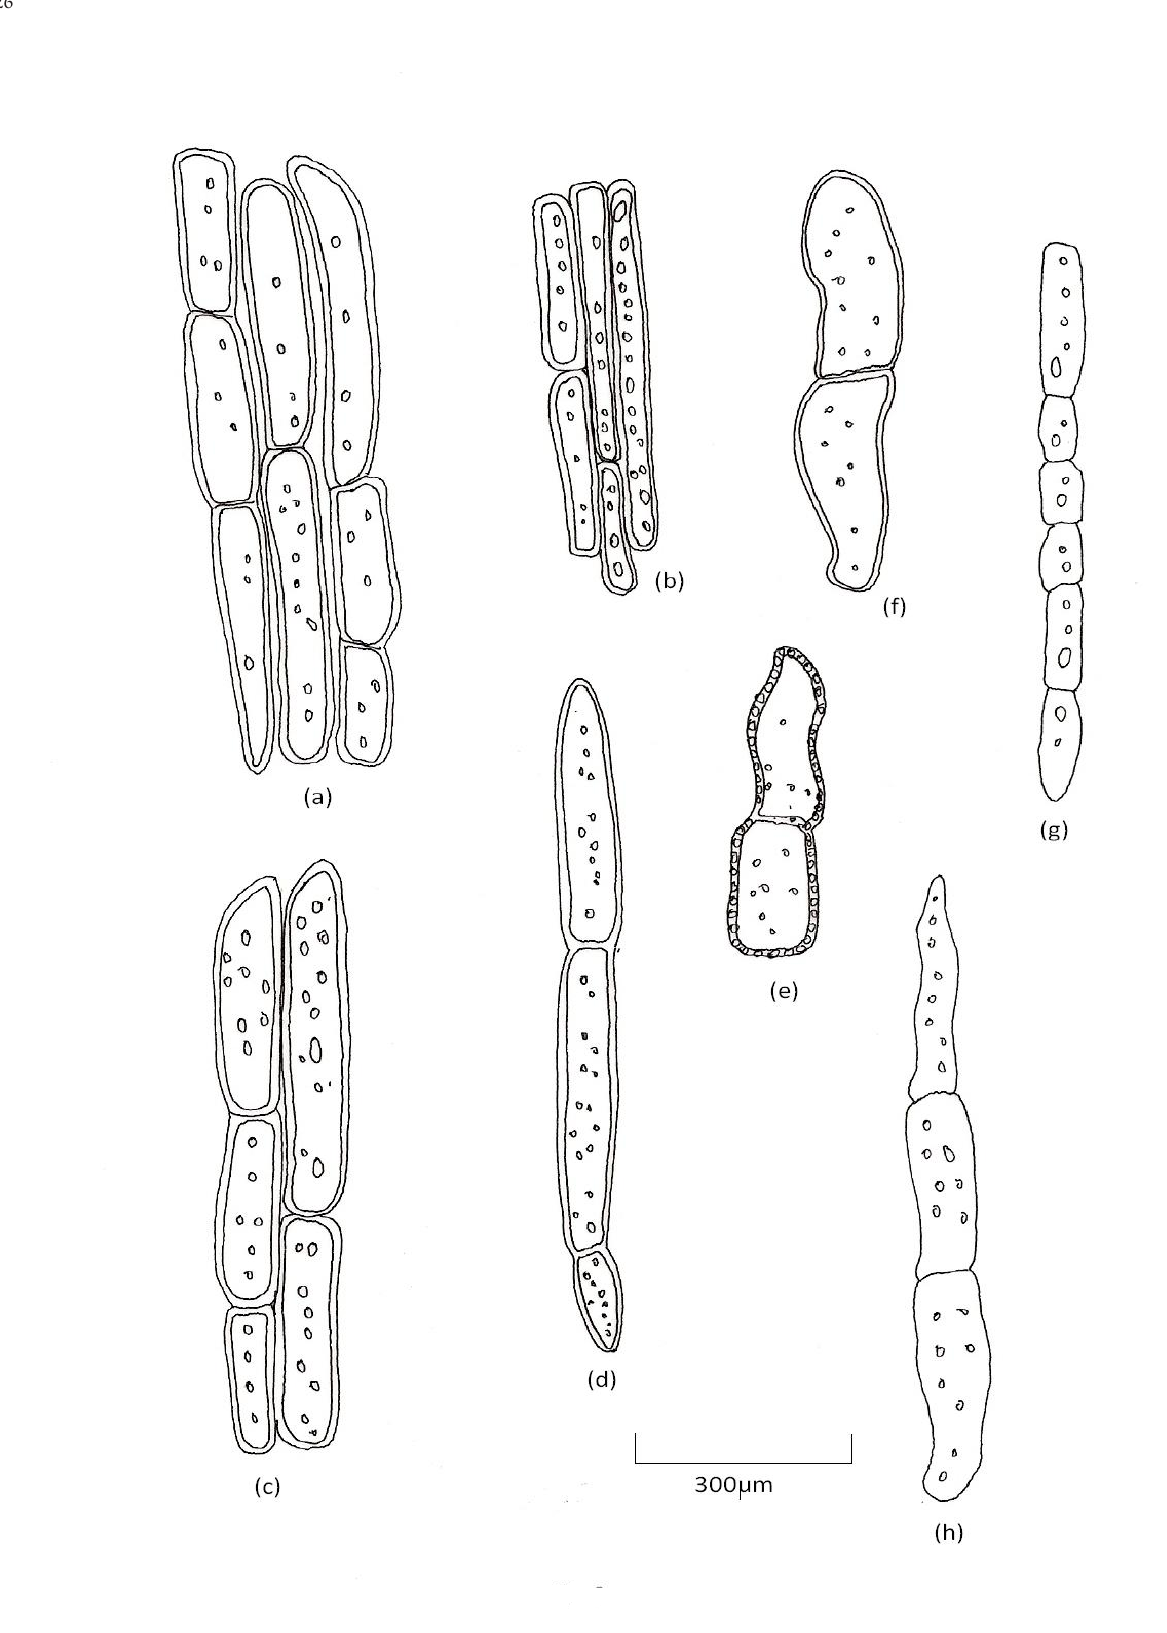
Fig. 3. Diagrammatic illustration of parenchyma cells of Annona senegalensis ; Diagram a-c: Ray parenchyma cells in Annona senega- lensis ; Diagram d-h: Axial parenchyma cells in Annona